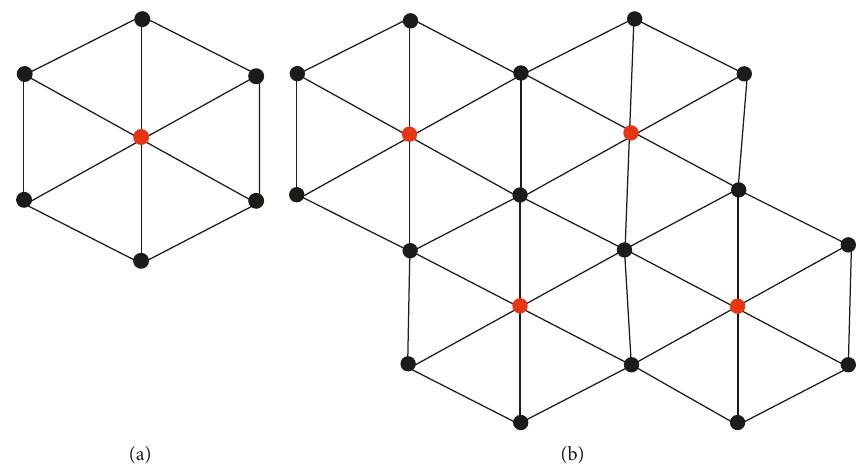
[ m, n ] . (b) Sb [ 2 , 2 ] . Two rows are Te Te 2 3 2 3